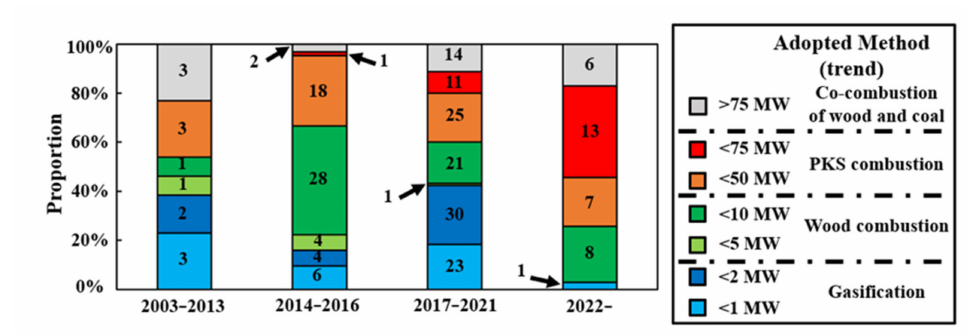
Figure 2. Proportion of woody biomass power generation projects by